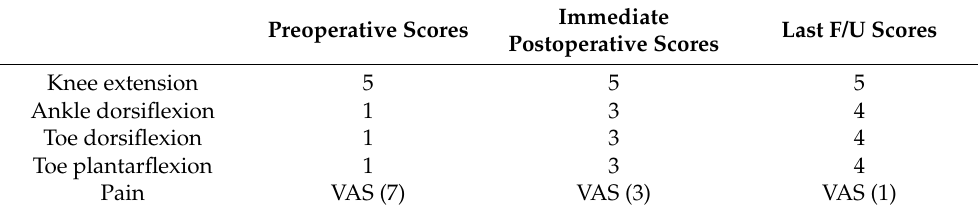
Table 1. Outcome and clinical